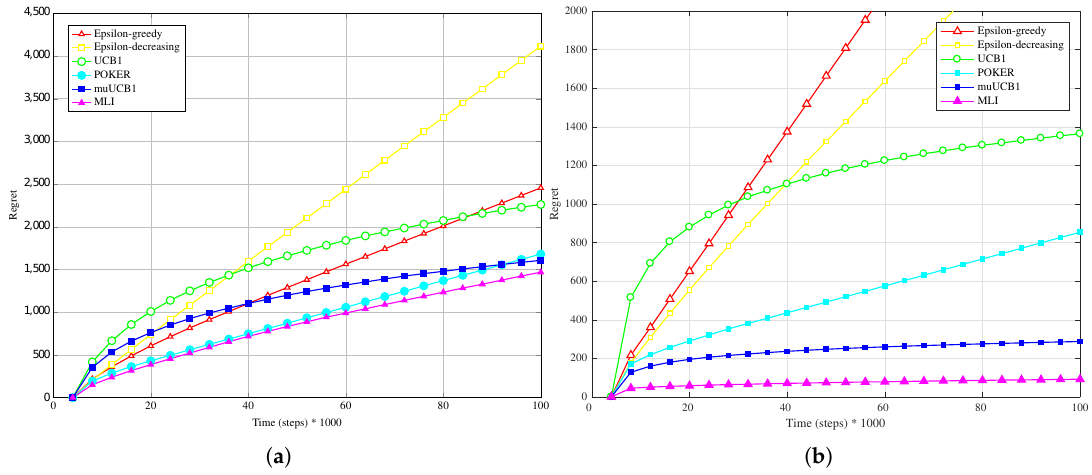
Figure 6. Performance in terms of regret of the six considered algorithms, with a truncated Gaussian distribution for the reward PDF and T U / T M = 10. ( a ) Hard configuration; ( b ) Easy configuration.